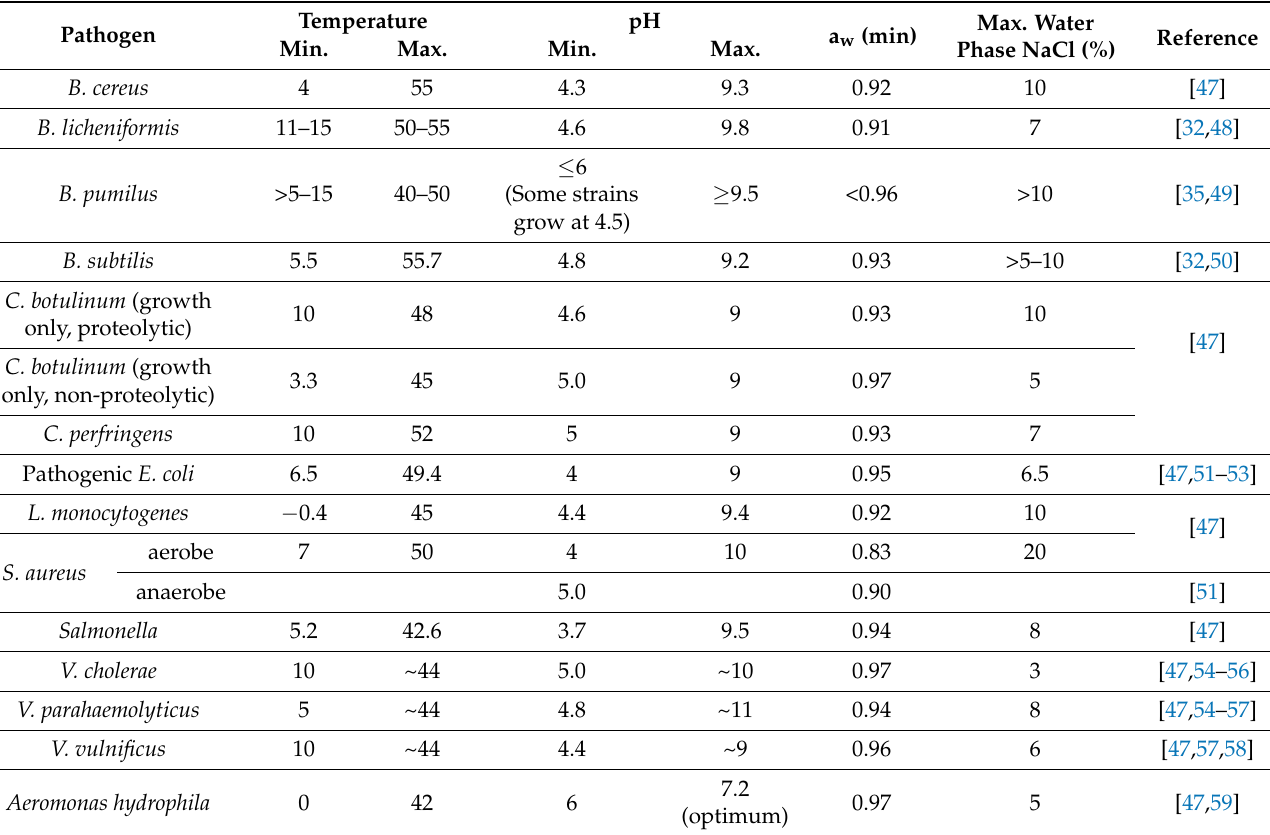
Table 2. Limits for growth under otherwise optimal conditions for some pathogenic bacteria of relevance for seaweeds. The data are relevant for safety and shelf life for traditional and novel seaweed food products under different processing and storage